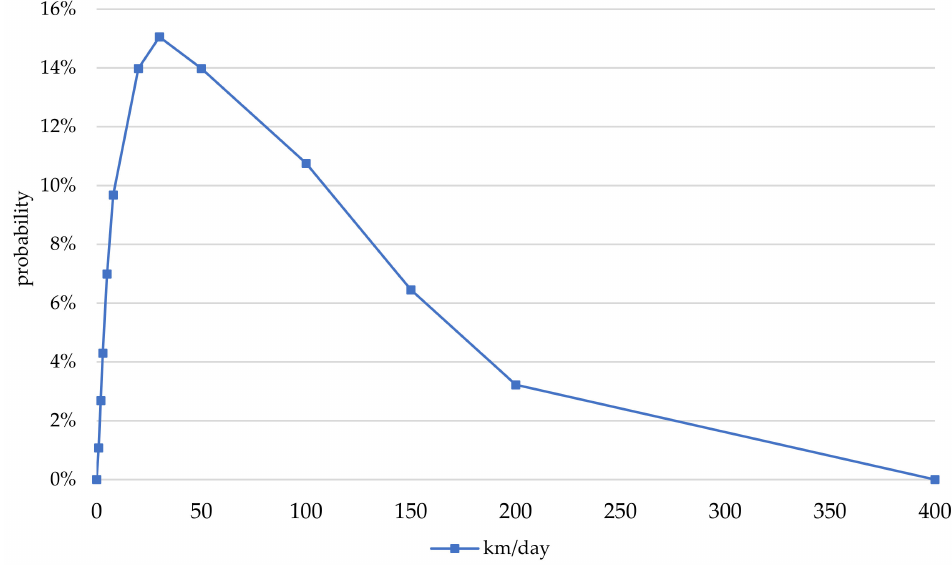
Figure 7. Probability density function of daily distance driven by car (compiled and calculated by authors from [67], Pareschi, G. et al.,